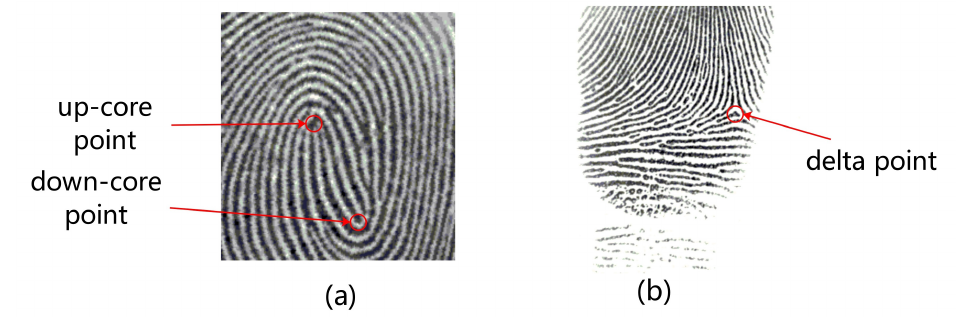
Figure 1. Fingerprint singular points: ( a ) core points, ( b ) delta